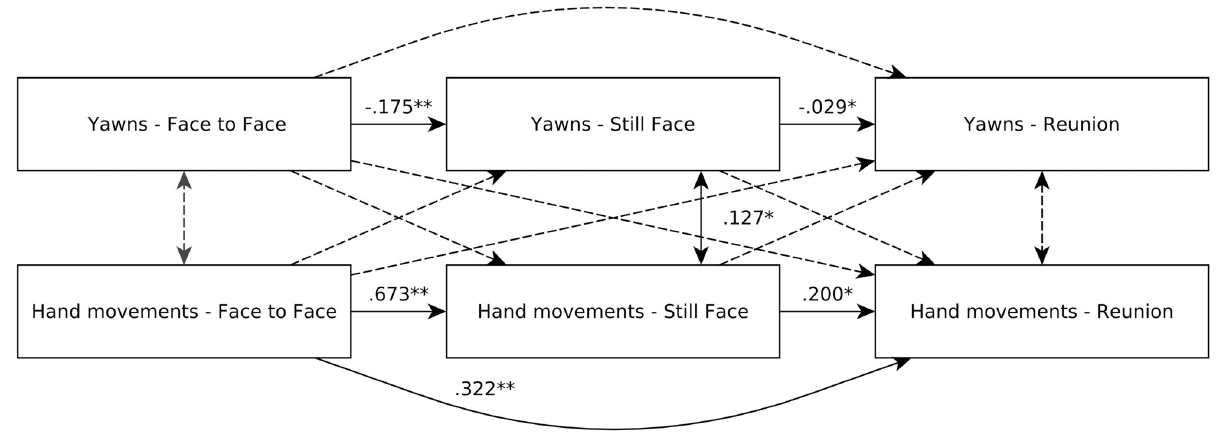
Fig 1. Path analysis